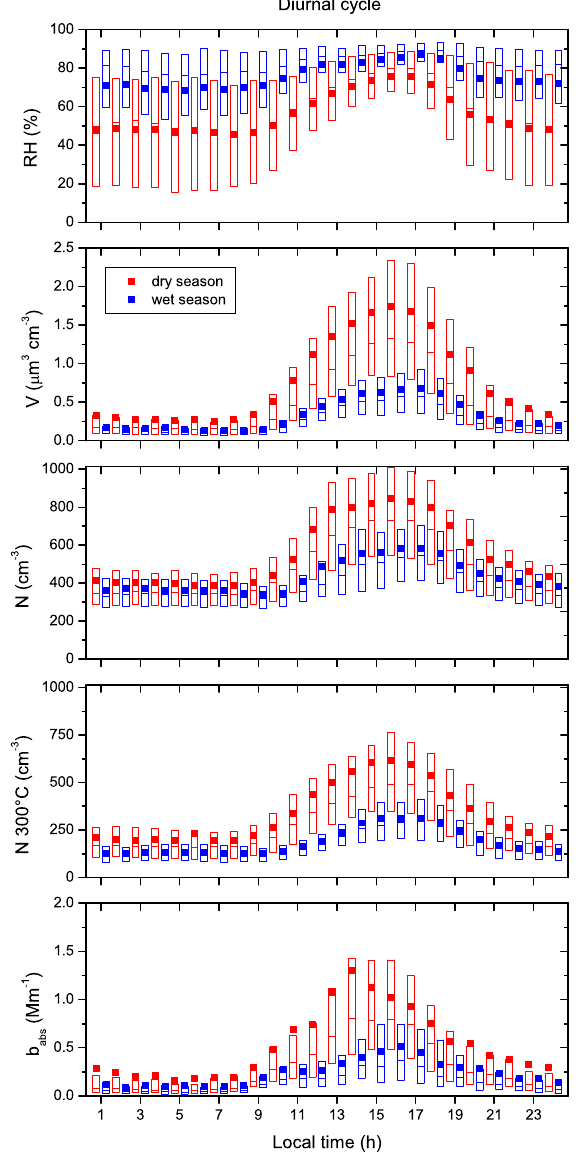
Fig. 5. Possible fire events affecting the observations according to the trajectory analysis (-10 days). Red triangles represent the Venezuelan dry season, blue triangles its wet season. Panel (a) shows all possible fire events not accounting for precipitation along the air mass transport path way. Panel (b) shows all fire events ex- cluding events with precipitation along the transport path way.